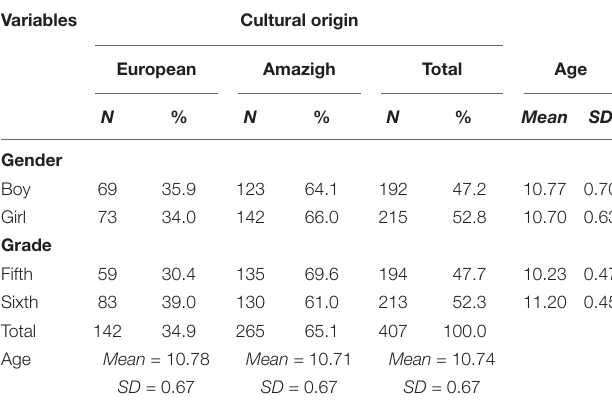
TABLE 2 | Distribution of participants according to cultural origin, gender, grade, and